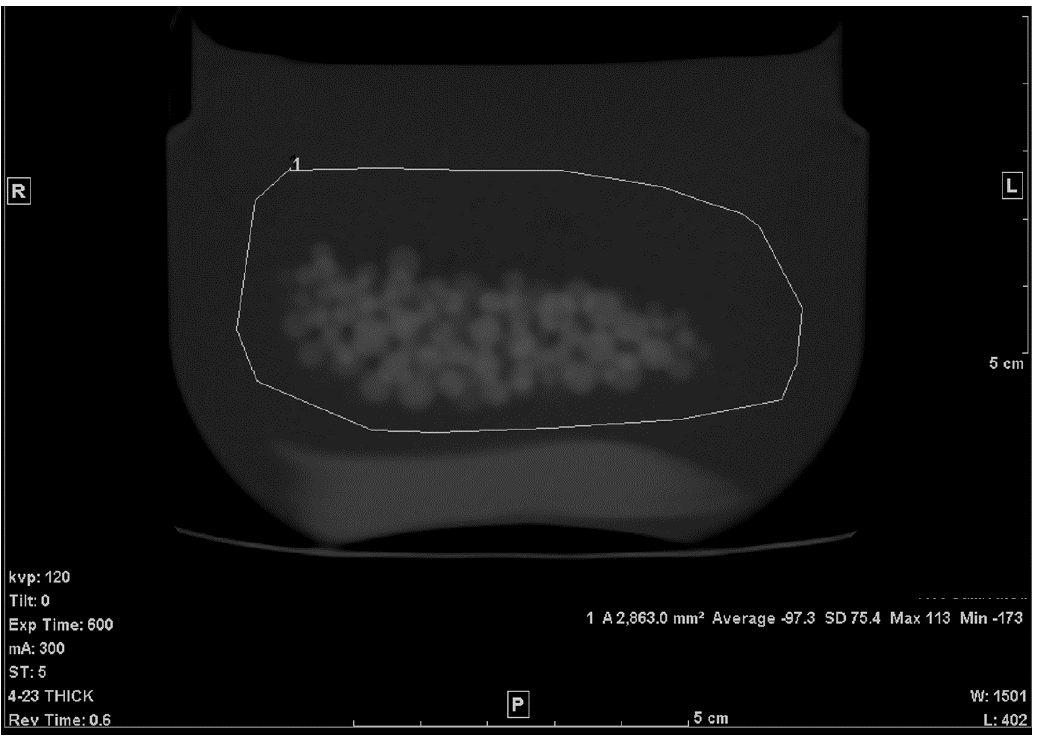
Figure 3. Large ROI (×2 the area of the original ROI).